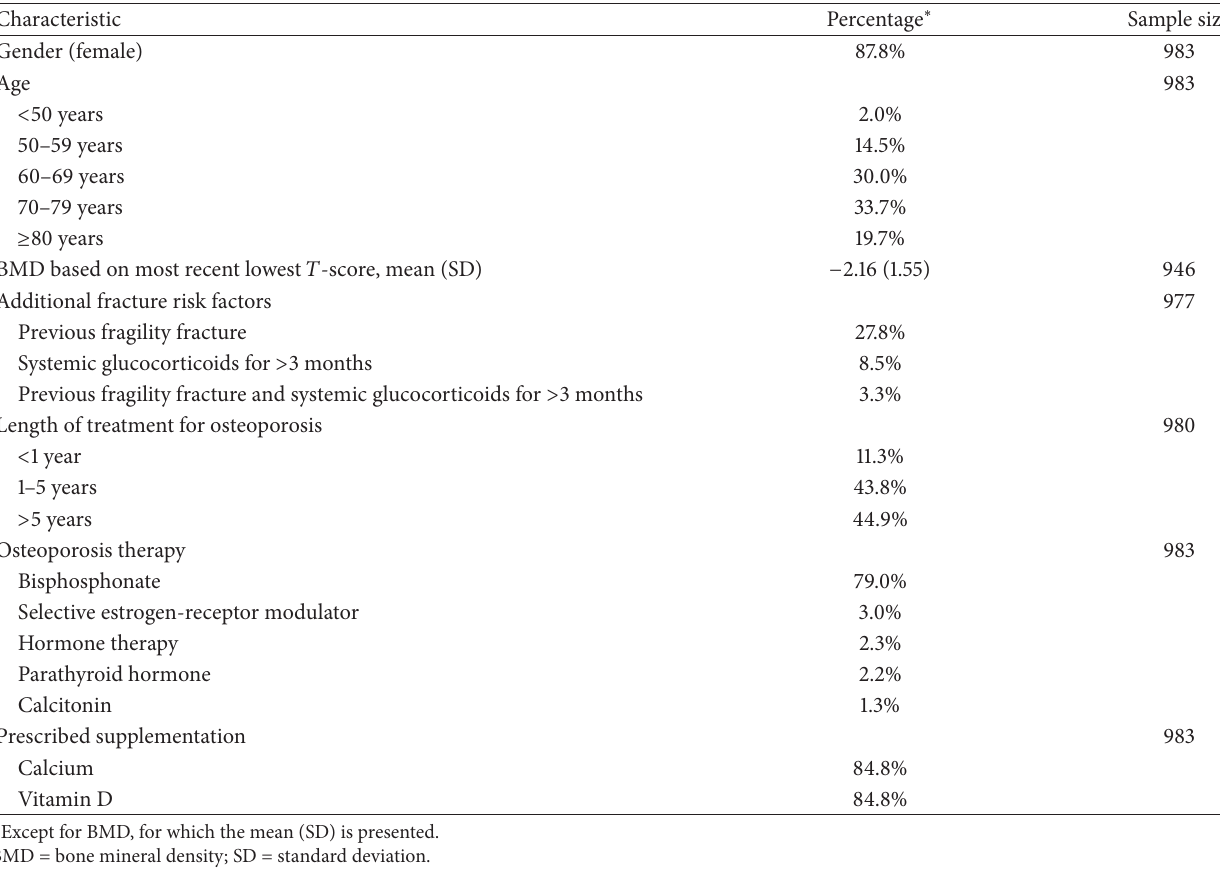
Table 1: Patient characteristics.